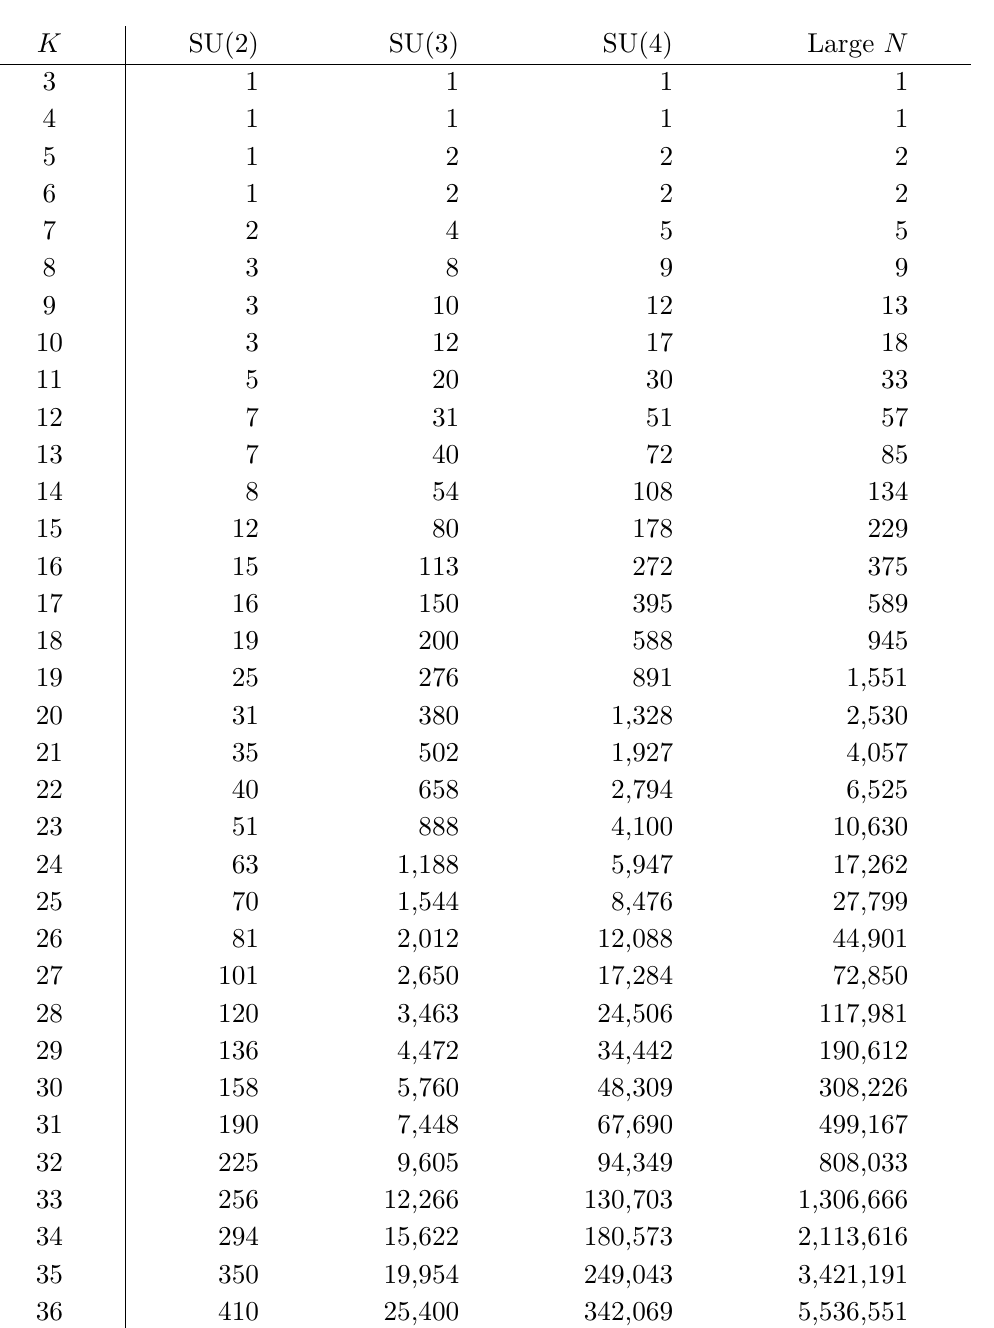
Table 2 . The numbers of states for K = 3 through 36 for SU(2) , SU(3) , SU(4) , and at large N (in the latter we include all possible multi-trace states). For any fixed value of N , we see that for sufficiently large K most of the states at large N become